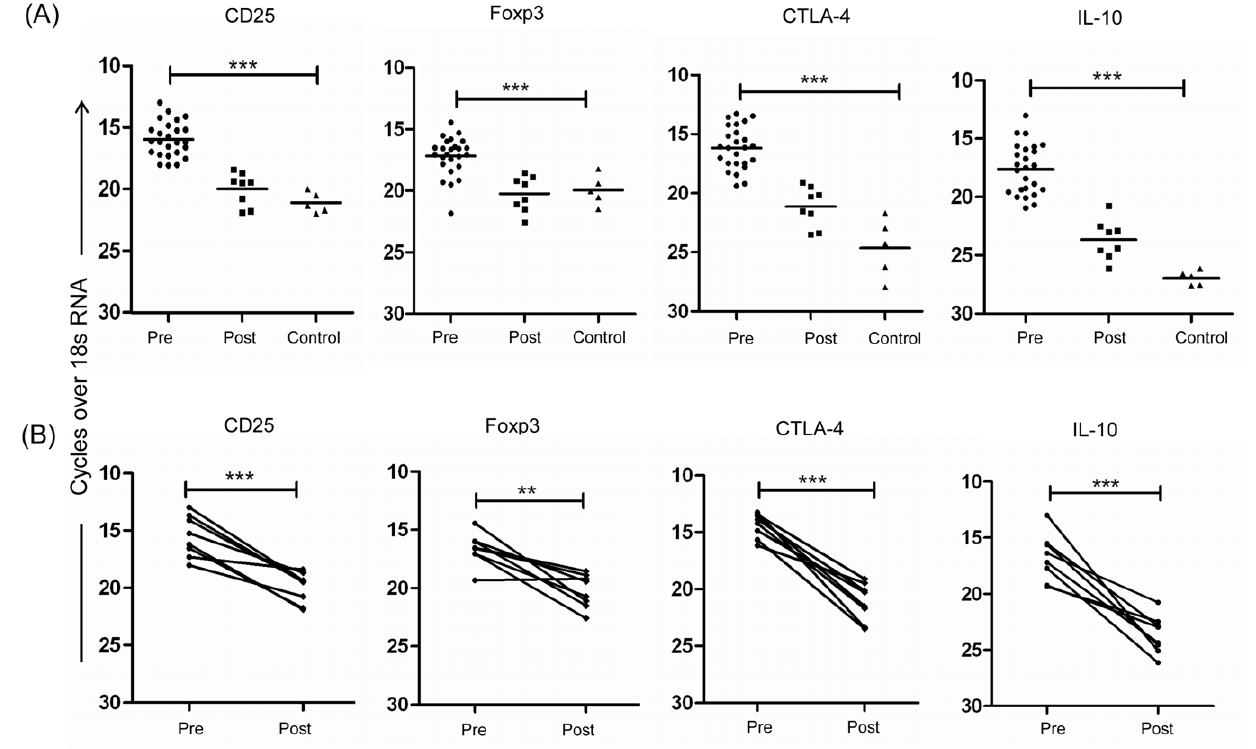
Figure 1. Exvivo analysis of mRNA expression of Treg markers and IL-10 in PKDL. Relative mRNA levels of CD25, Foxp3, CTLA-4 and IL-10 in lesion tissues of PKDL patients determined by real time polymerase chain reaction at pretreatment (n=25) or post treatment (n=8), or control tissues (n=5) (A) and in paired samples (n=8) shown separately (B). **P , 0.01, and ***P , 0.001.